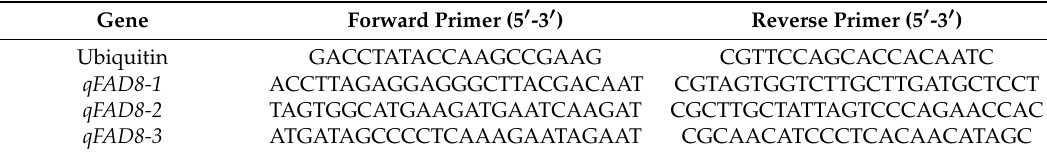
Table 1. Primers and sequences of PoFAD8-1 , PoFAD8-2 , and PoFAD8-3 gene cloning.